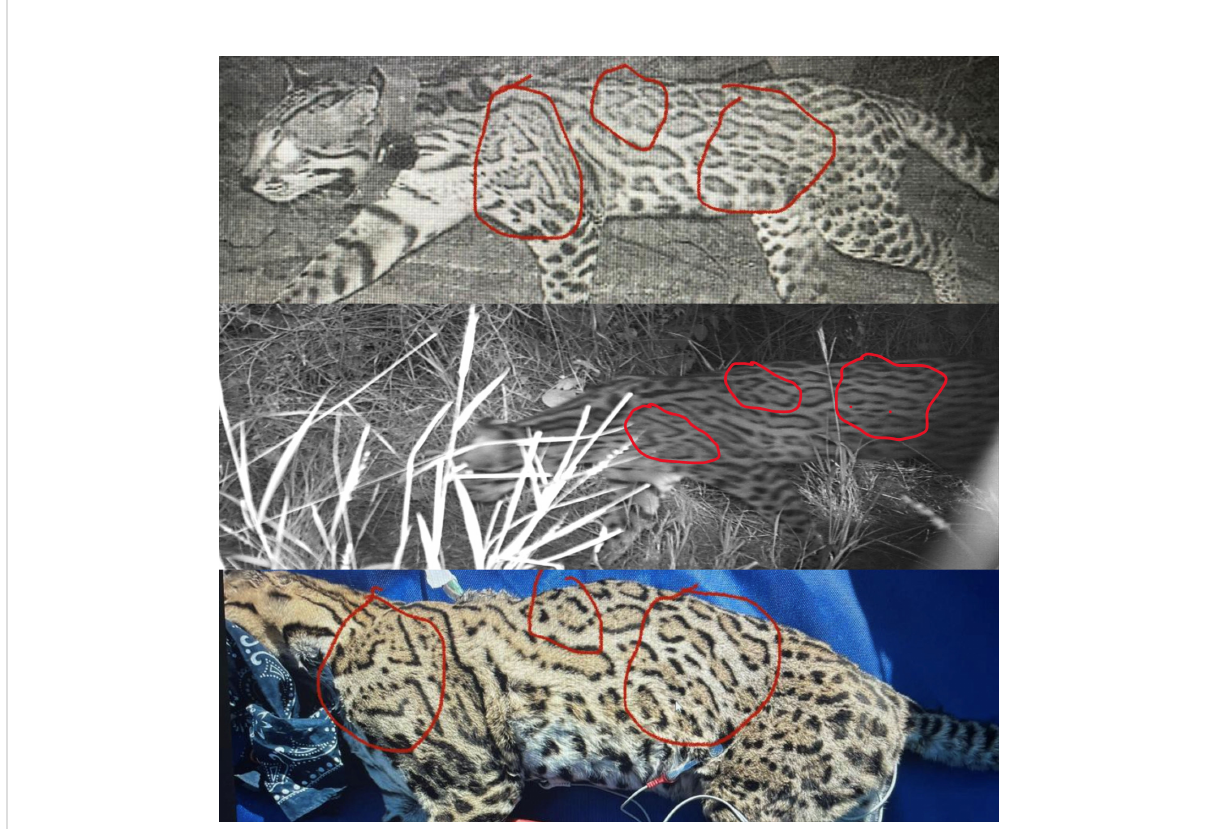
FIGURE 2 Example of individual ocelot identi fi cation using unique pelage patterns of an adult female ocelot ( Leopardus pardalis pardalis ) based on photographs from ocelot camera trap identi fi cation library (top), this study (middle), and live capture (this past year) on the East Foundation ’ s El Sauz Ranch, Texas in Willacy and Kenedy counties, Texas. Red circles indicate each unique pelage pattern (rosettes and spots) on the side of the upper shoulder, upper back, and hind